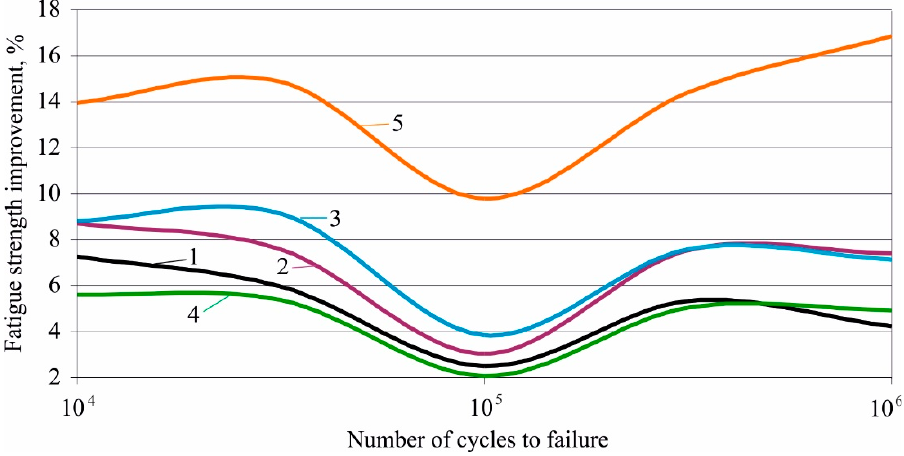
Figure 14. Fatigue strength improvement via DB: 1—as received, 2—annealed, 3—quenched, 4—quenched and tempered at 600 °C, 5—quenched and tempered at 300 °C.